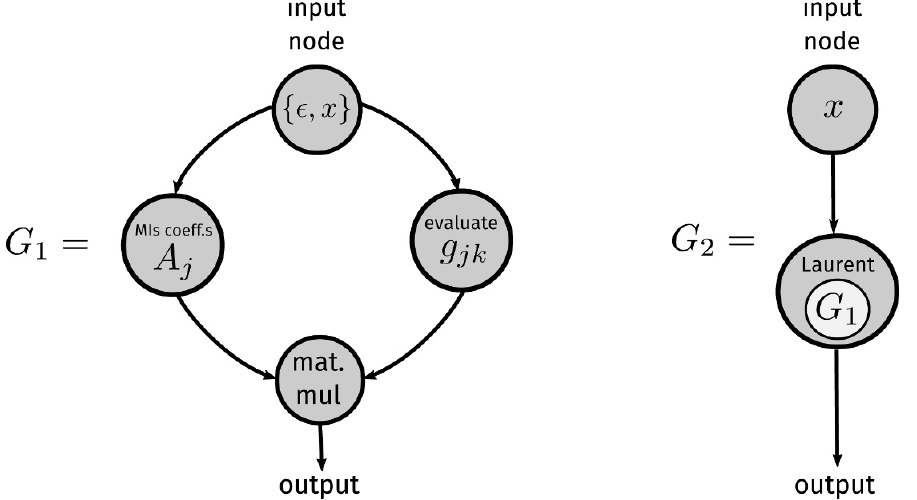
Figure 6 . Two graphs which, combined, compute the (cid:15) expansion of the coe(cid:14)cients of scattering amplitudes in terms of special functions. In the (cid:12)rst graph G 1 , A j represents the calculation of the coe(cid:14)cients of the master integrals presented in section 5.1 and (cid:12)gure 5. The graph G 2 then